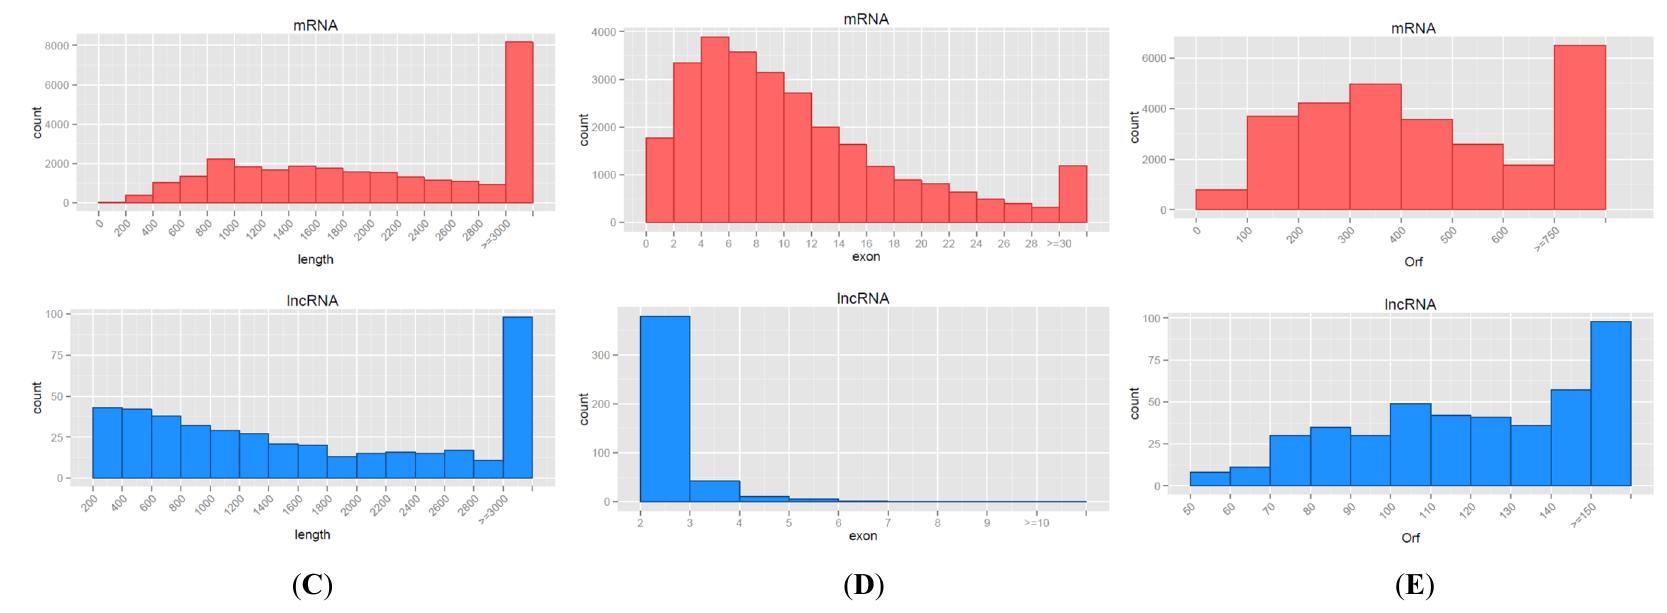
Figure 2. Characteristics of lncRNAs. ( A ) Expression-level analysis for messenger RNAs (mRNAs) and lncRNAs. ( B ) Conservative analysis of sequences in mRNAs and lncRNAs. ( C ) Length distribution of mRNAs (red) and lncRNAs (blue), unit of the length is bp. ( D ) Exon number distribution for mRNAs and lncRNAs. ( E ) Open reading frame (ORF) length distribution for mRNAs and lncRNAs.